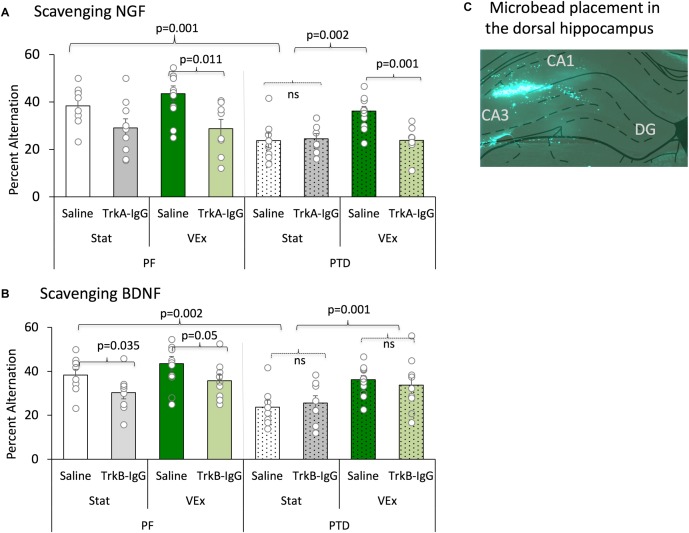
Spontaneous alternation is displayed with the sequestering of NGF [(A) (TrkA-IgG) and BDNF (B) (TrkB-IgG)], and is expressed as mean percent alternation ± SEM. Exercise (green bars) completely ameliorated the spontaneous alternation impairment in PTD-treated rats; conversely, blocking NGF (light green bars) completely abolished the exercise related recovery in PTD rats, and diminished performance in PF rats. Blocking BDNF impaired performance in PF control rats, regardless of exercise status. In contrast, inhibiting the actions of BDNF had no effect on the behavior of PTD-treated rats. Microbead placement is observed from a green fluorescent image taken of the dorsal hippocampus with 5× objective lens (C).